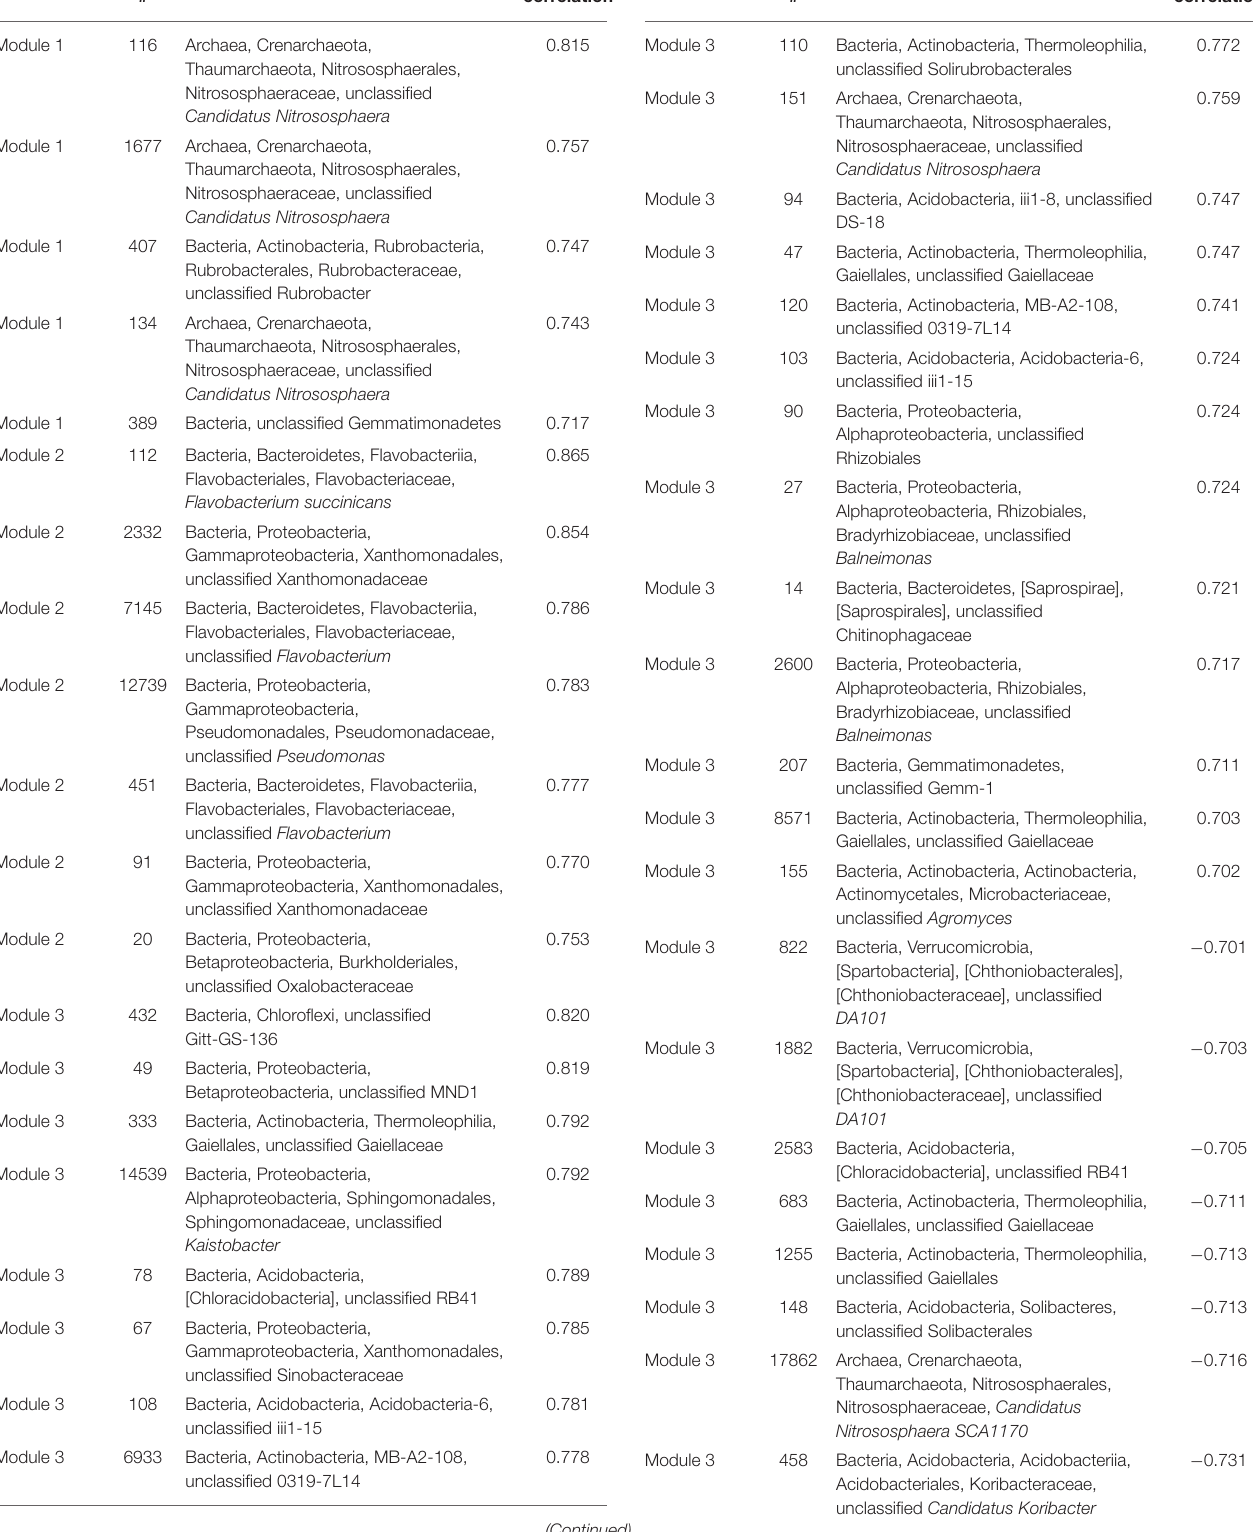
TABLE 2 | 16S hub taxa by